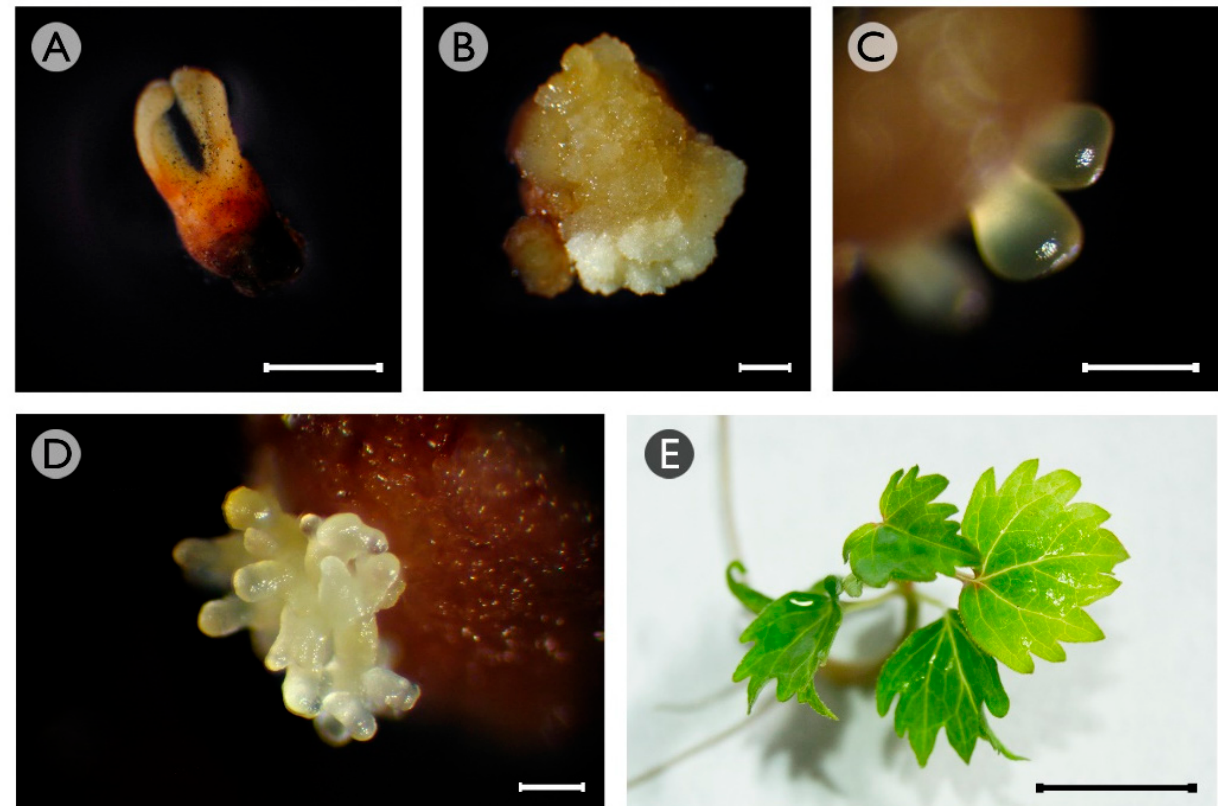
Figure 1. Responses observed in grapevine cv. Mencía cotyledonary somatic embryos. ( A ) Cotyledonary somatic embryo with no response and signs of necrosis after eight weeks of culture in an induction medium with 5 mM NaB. ( B ) Non- embryogenic callus originating from cotyledonary somatic embryos that were cultured in an induction medium without HDAC inhibitors for eight weeks. ( C ) Proembryos formed on the surface of cotyledonary somatic embryos that were cultured in an induction medium with 0.5 mM NaB for eight weeks. ( D ) Somatic embryo aggregate formed by secondary embryogenesis of proembryos formed from cotyledonary somatic embryos that were cultured in an induction medium with 0.5 mM NaB for eight weeks. ( E ) Grapevine microplant regenerated from somatic embryos induced in cotyledonary somatic embryos that were cultured in an induction medium with 0.5 mM NaB. Bars: 1 mm ( A , B ); 0.5 mm ( C , D ); 1 cm ( E ).